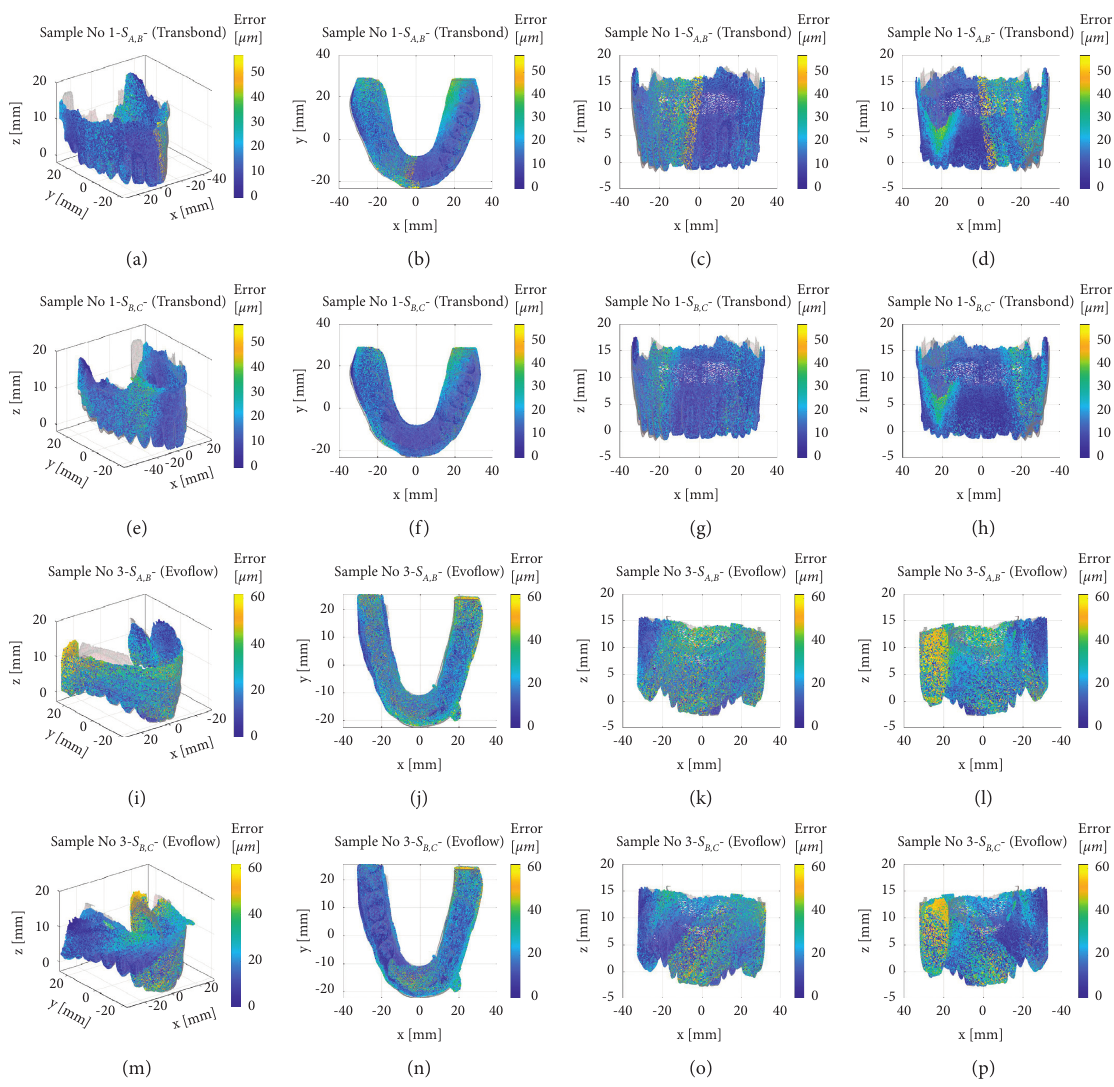
Figure 2: (a–d) Scatter plots of the relative distance between the A and B samples obtained with TetricEvoflow, Ivoclar Vivadent composite. The plot refers to sample no. 3. (e–h) Scatter plots of the relative distance between the B and C samples obtained with Transbond ™ XT Light Cure Paste Adhesive, 3M composite. The plot refers to sample no. 3. (i–n) Scatter plot of the relative distance between the A and B samples obtained with TetricEvoflow, Ivoclar Vivadent composite. The plot refers to sample no. 3. (o–r) Scatter plot of the relative distance between the B and C samples obtained with TetricEvoflow, Ivoclar Vivadent composite. The plot refers to sample no.